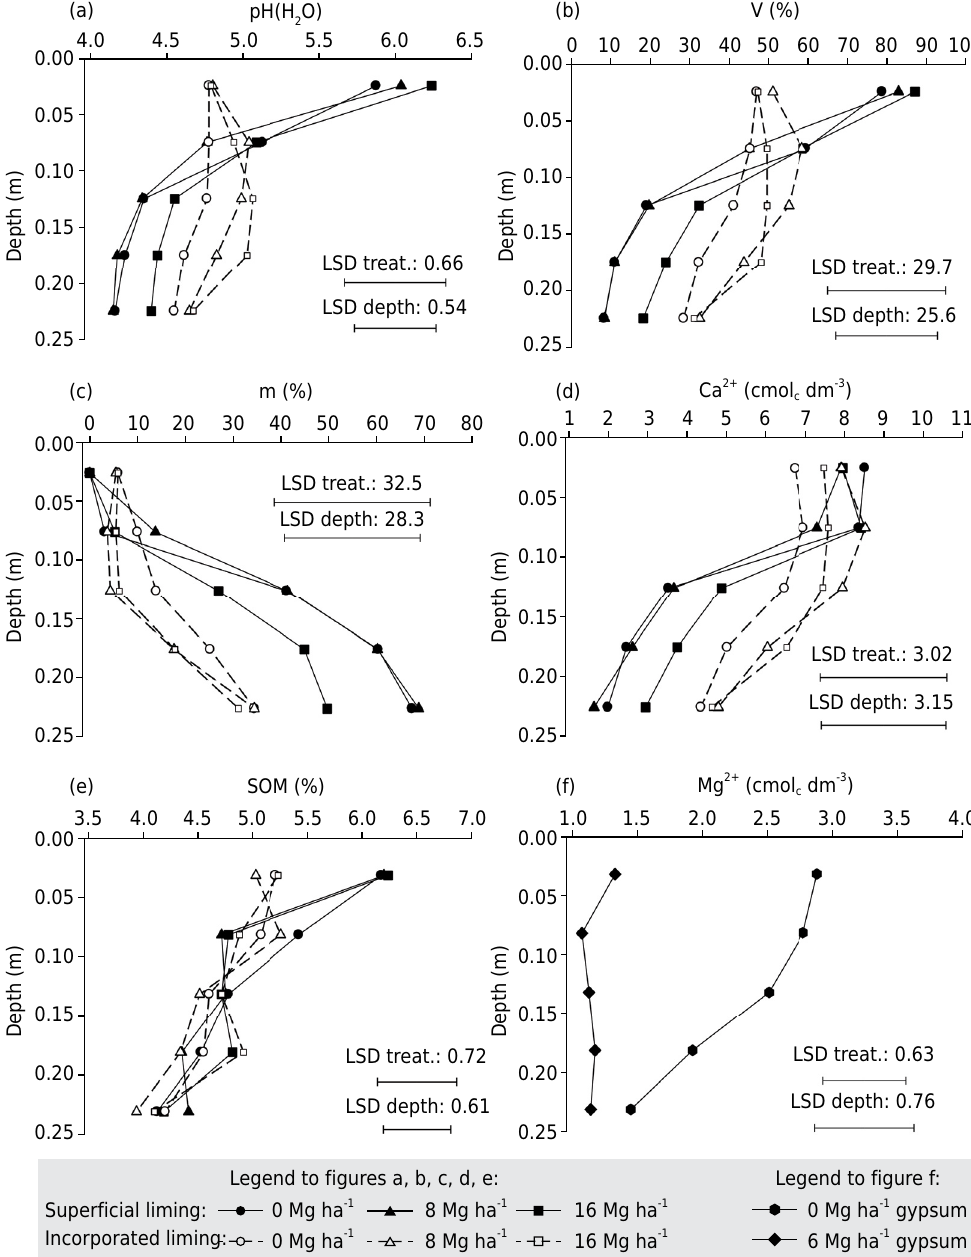
Figure 1. Effect of treatments on pH in water – pH(H 2 O) of the soil (a) base saturation – V (b), Al saturation – m (c), Ca 2+ content (d), soil organic matter – SOM (e) and Mg 2+ content (e). Horizontal bars represent the least significant differences by the Tukey test (p≤0.05) for the applied treatments (LSD treat) and evaluated layers (LSD